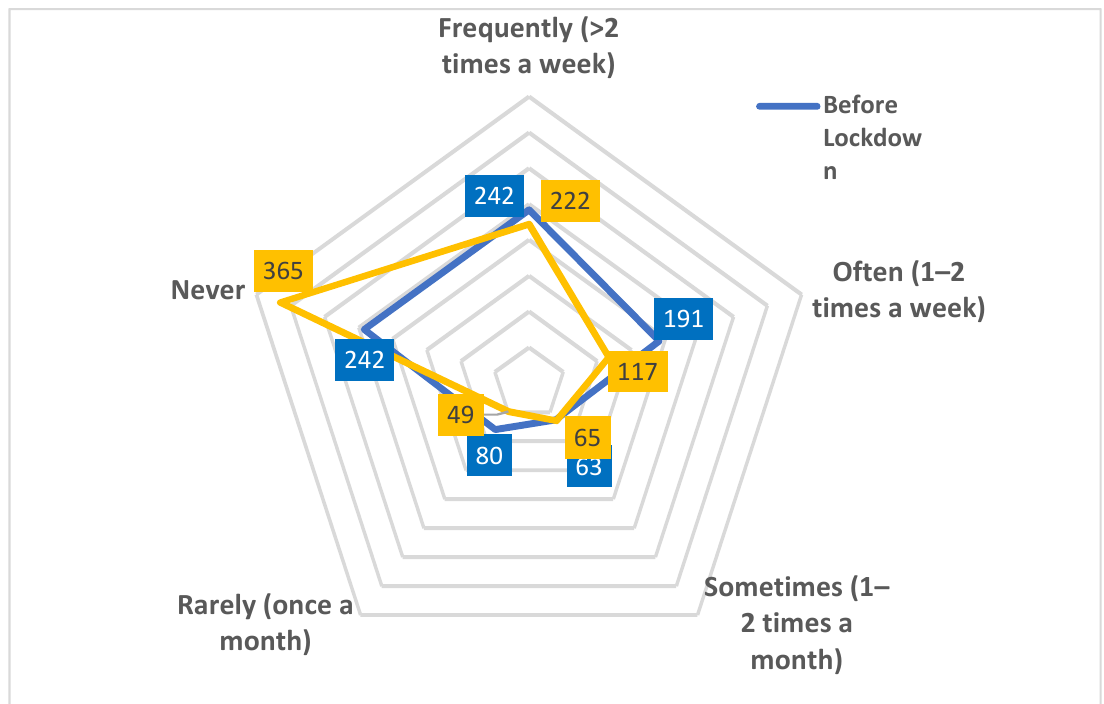
Figure 1. Frequency of using gym or exercise classes before and during lockdown, shown by number of participants for each category.